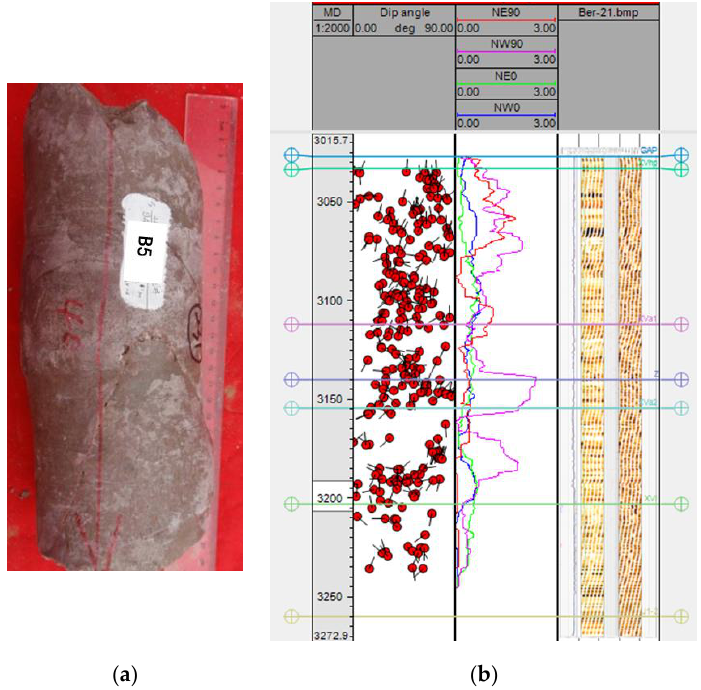
Figure 8. Single well fracture analysis: ( a ) core of well B5 at 3170.58 m; ( b ) fracture density interpretation of different fracture sets for well B5.